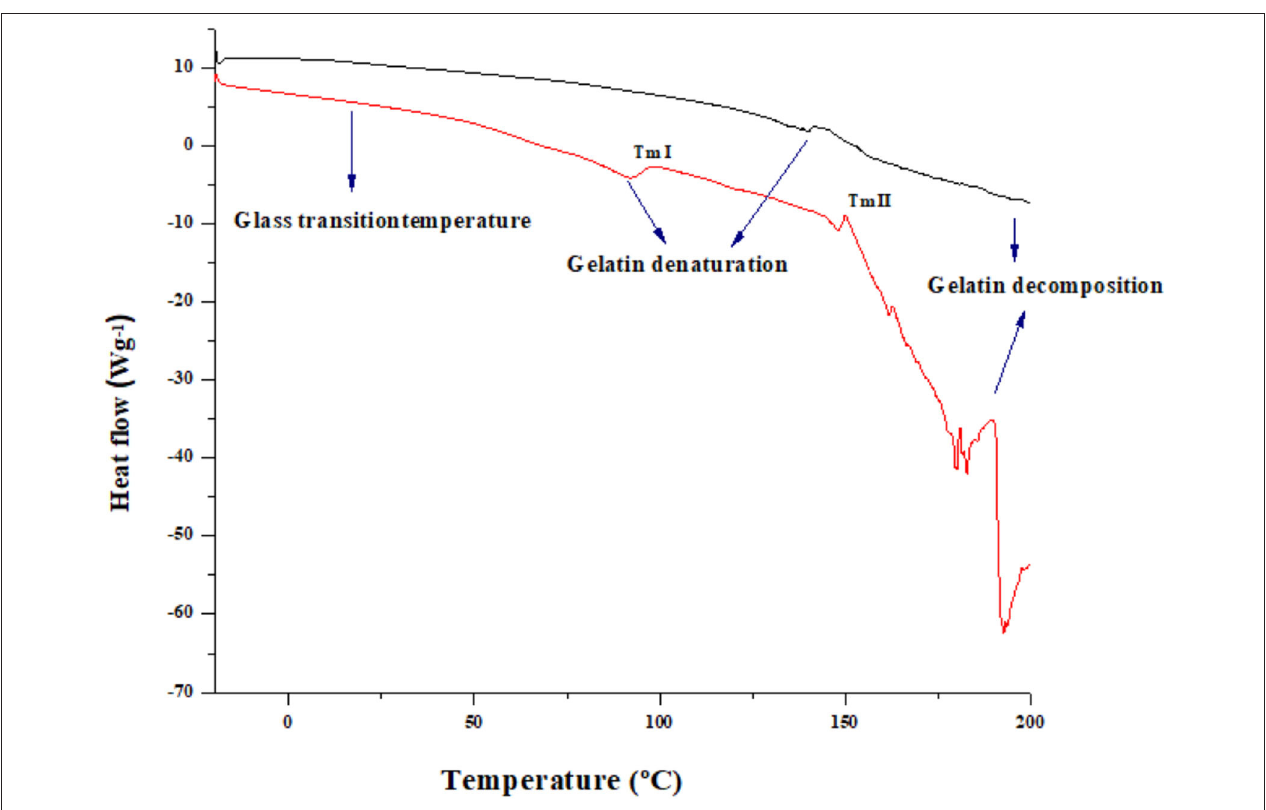
FIGURE 2 | The DSC analysis of HAD ( ) and FD ( )